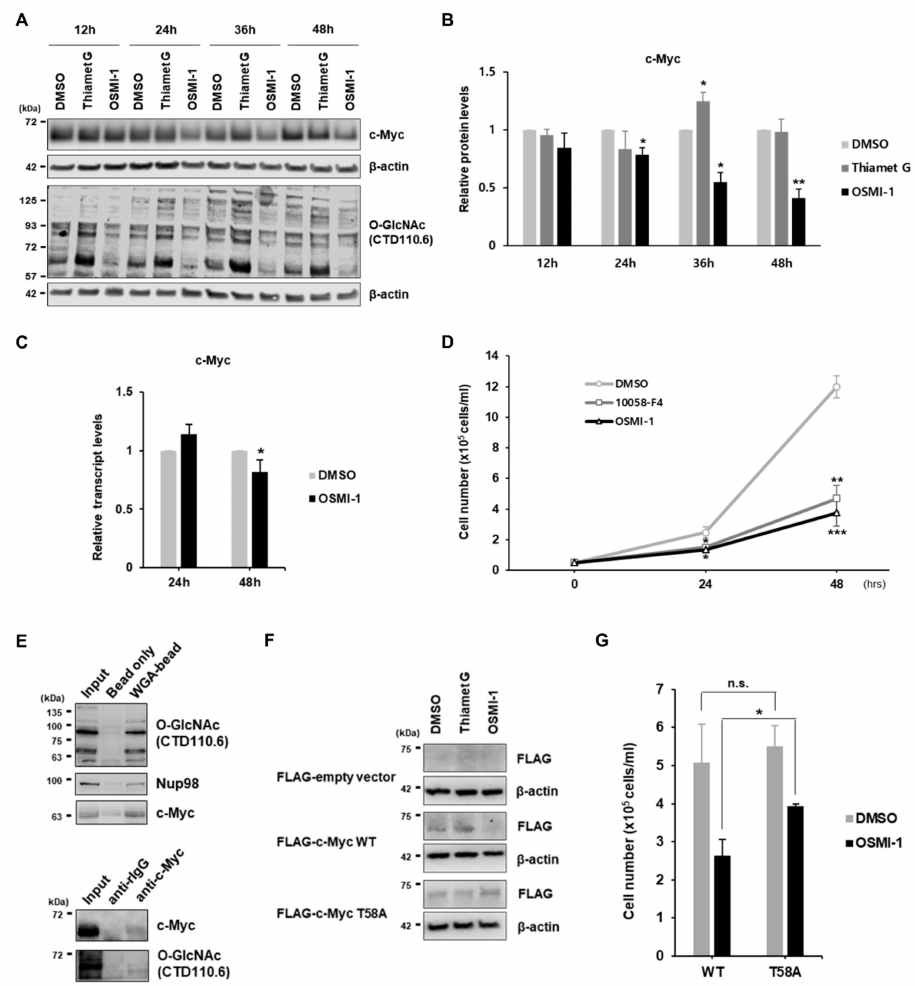
Figure 3. Stability of the c-Myc protein is substantially downregulated by inhibition of O-GlcNAcylation in pre-B cells. (A ) Representative western blot to monitor changes in c-Myc protein levels and overall O-GlcNAcylation in PD36 pre-B cells cultured with inhibitors, Thiamet G (OGA inhibitor; 2 µ M final) and OSMI-1 (OGT inhibitor; 10 µ M final), for 48 h. ( B ) Quantification of c-Myc protein levels from the western blot in ( A ). Data are represented as mean ± SD ( n = 3) normalized using β -actin as a loading control. Comparisons were performed using the DMSO control at each time point. ( C ) Real-time qRT-PCR analyses of changes in transcript levels of c-Myc in PD36 pre-B cells at 24 or 48 h post-treatment with OSMI-1 (10 µ M, final). Data are represented as mean ± SD ( n = 3) normalized using β -actin as a loading control. Comparison between OSMI-1 treatment and DMSO control. ( D ) Cell growth of PD36 pre-B cells for 48 h following inhibitor treatment (10058-F4 (Myc inhibitor; 50 µ M final) and OSMI-1 (OGT inhibitor; 10 µ M final)). The growth curve was generated by counting cells every 24 h. Data are represented as mean ± SD ( n = 3). Comparisons were performed against the cell number in DMSO-treated control at each time point. ( E ) Western blot images, following pull-down using WGA-lectin conjugated to agarose beads (top) or immunoprecipitation of c-Myc proteins using an anti-c-Myc antibody with protein A-magnetic beads (bottom), to determine O-GlcNAc attachment to c-Myc proteins. ( F ) Representative western blot showing overexpressed protein levels of FLAG-c-Myc (WT or T58A) using the anti-FLAG antibody at 24 h post-treatment with Thiamet G (2 µ M final) or OSMI-1 (10 µ M final). ( G ) Cell growth of PD36 pre-B cells for 24 h under OSMI-1 (10 µ M final) treatment following overexpression of FLAG-c-Myc (WT or T58A). Data are represented as mean ± SD ( n = 3). Comparisons between WT and T58A were indicated. ( B – D , G ) Significance is annotated as * p ≤ 0.05, ** p ≤ 0.01, and *** p ≤ 0.001. n.s. = not